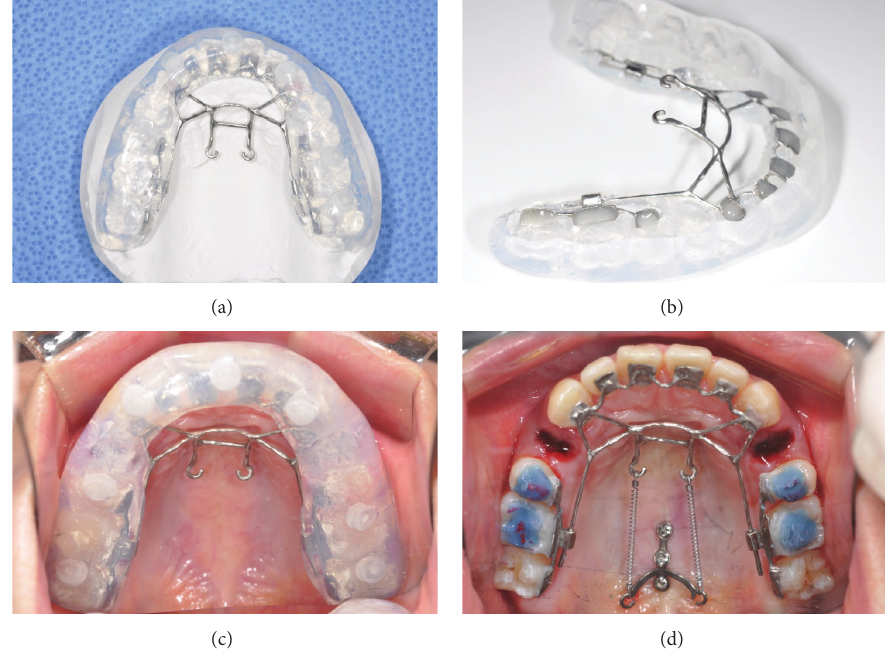
Figure 5: Bonding procedure. (a) Occlusal view of the transfer jig. (b) Resin was applied on the bonding surface of the appliance. (c) The appliance was bonded on the upper arch using a transfer jig. (d) A TSAD was placed and a closed-coil spring was inserted between the TSAD and KILBON